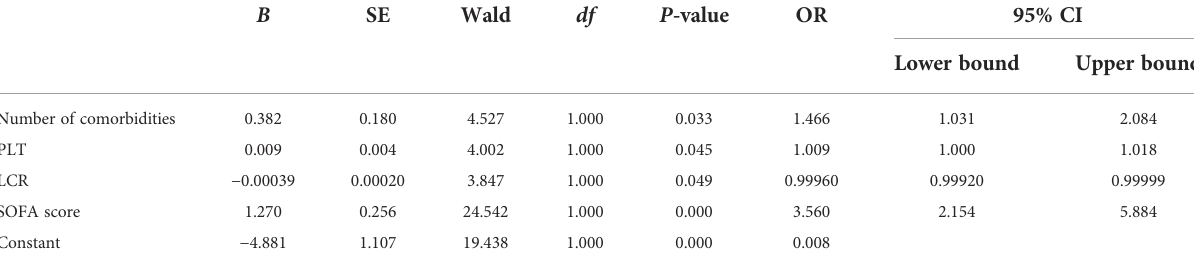
TABLE 6 Analysis of the related factors to classify COVID-19 patients into severe and critical groups. B SE Wald